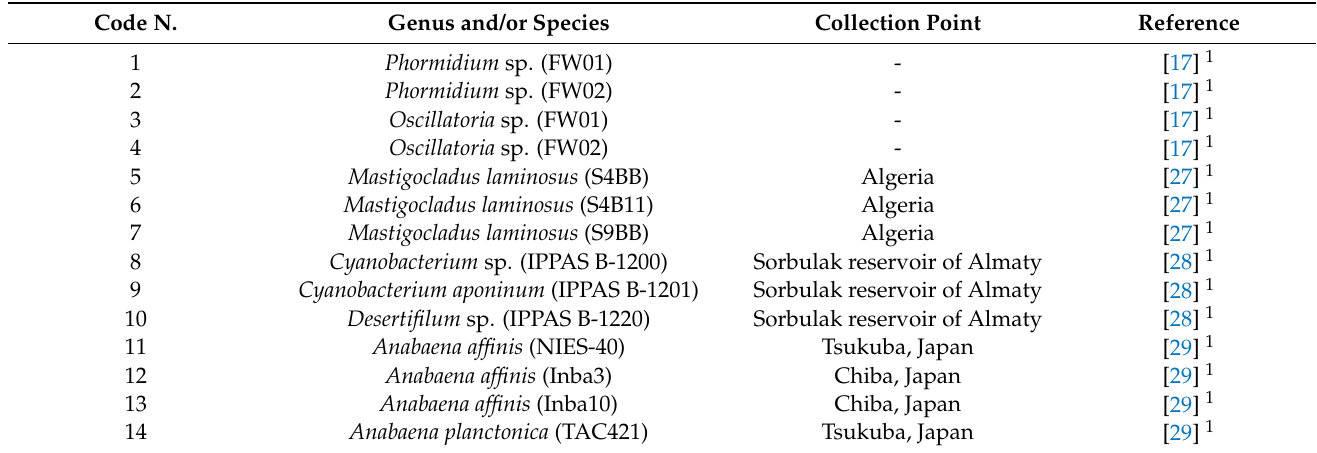
Figure 2. The number of publications (2000–2023) referring to the concentrations of lipids, fatty acids, carbohydrates, and proteins in freshwater cyanobacteria. Table 1. Main information about classification, collection point, and the literature reference relating to the fatty acid composition of the cyanobacteria selected for this review [14,16,17,27–46]. Code